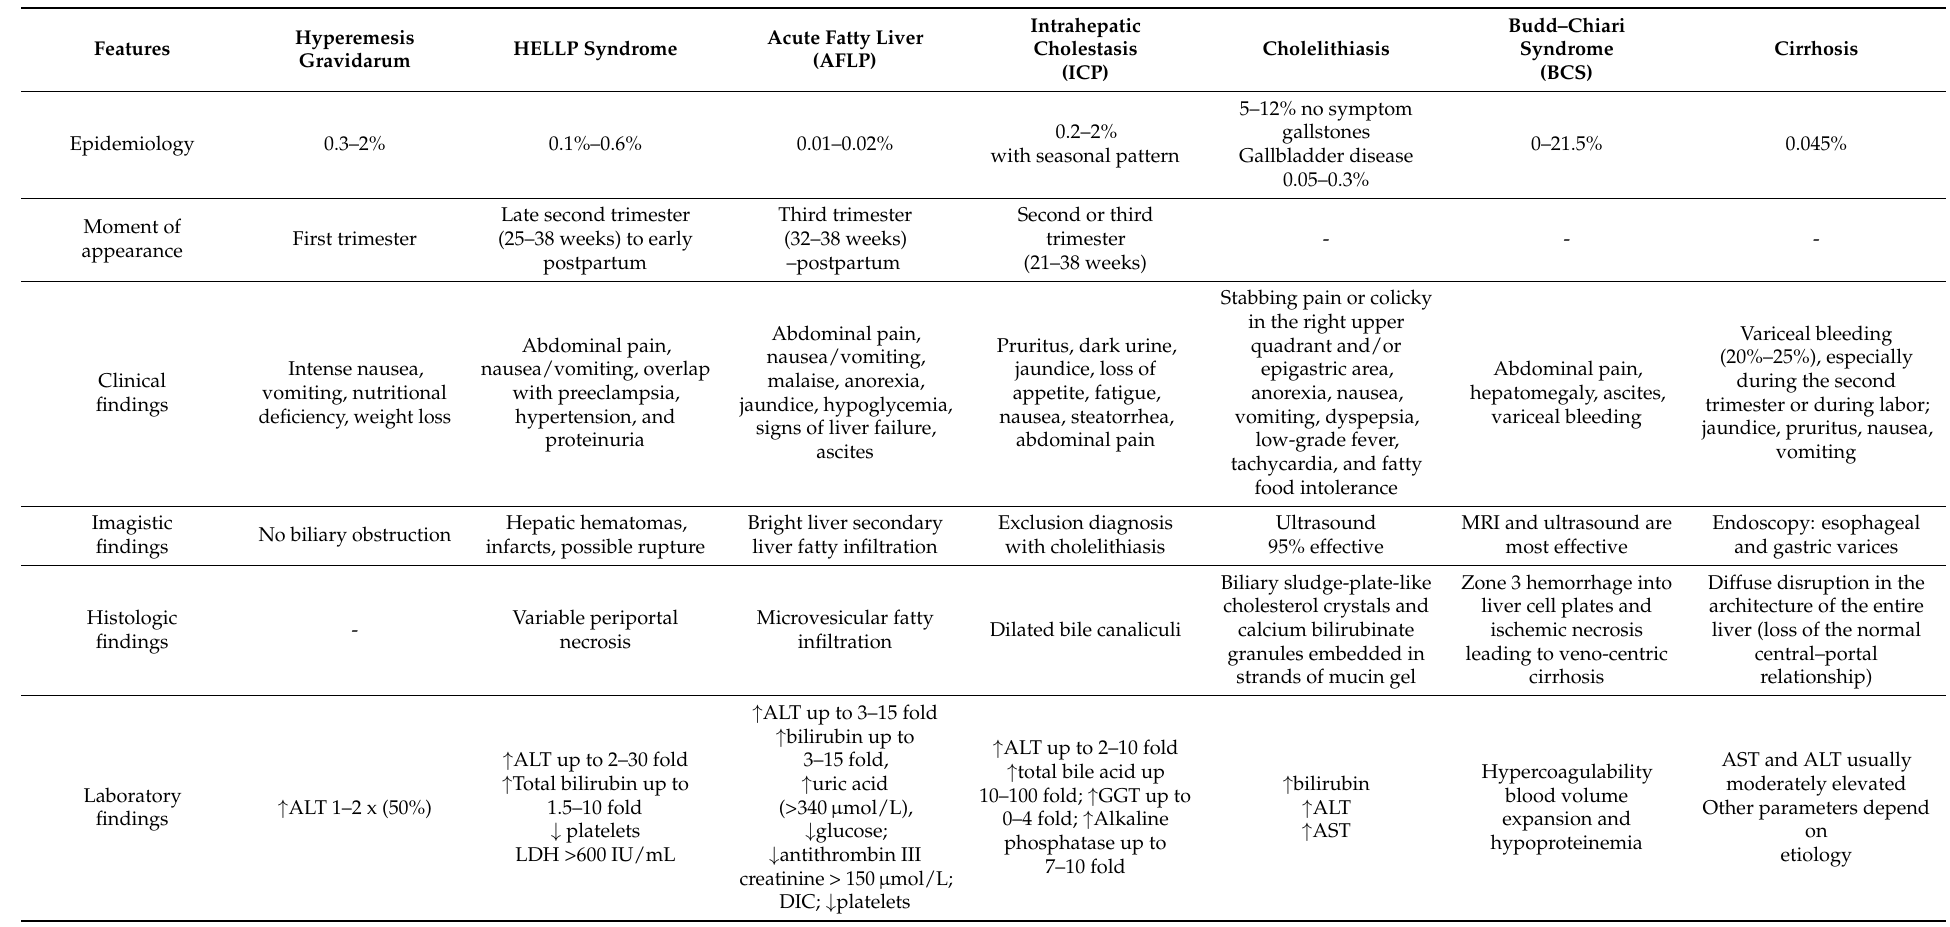
Table 5. Synopsis across the main findings in hepatic dysfunction in pregnancy. ERCP: endoscopic retrograde cholangiopancreatography; DIC-: disseminated intravascular coagulation; NICU: neonatal intensive care unit; MELD score: model for end-stage liver